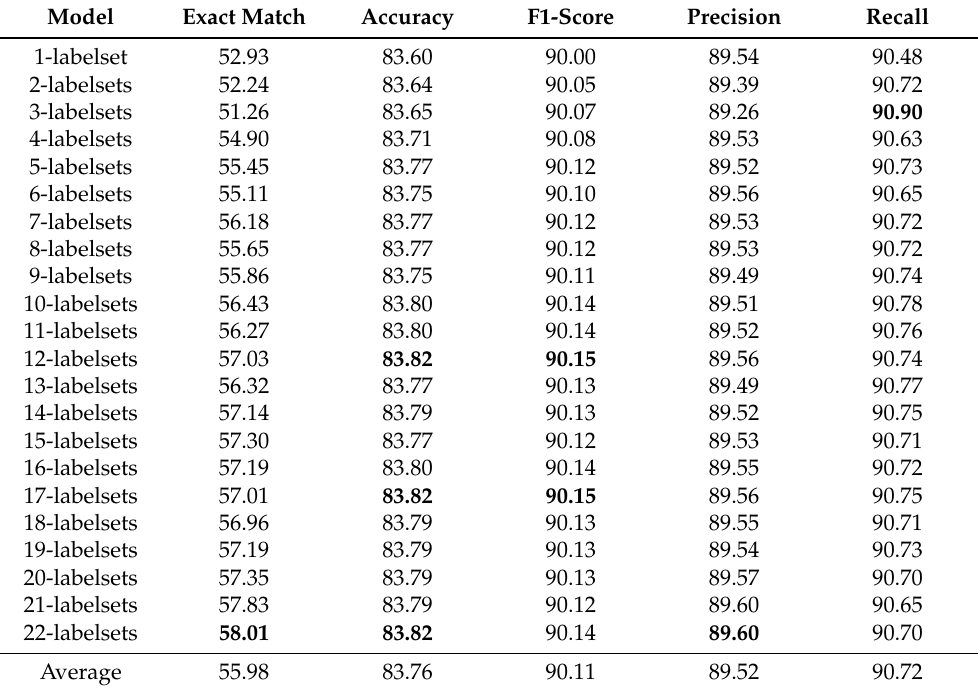
Table 4. Classification performance for the proposed model with k -labelsets based on subclass (The proposed model with k -labelsets uses SE-ResNet-34 as a